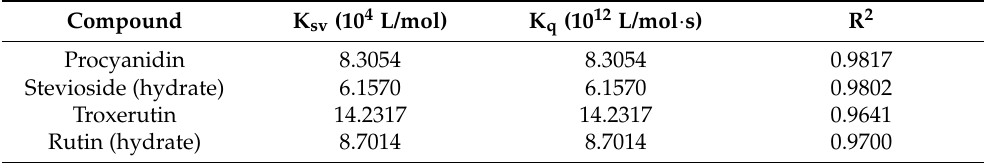
Figure 4. Fluorescence quenching type for the interaction between different compounds and LolB. ( A ): Stern – Volmer plots. ( B ): Plots of compound concentrations vs. changes in fluorescence intensity using One Site-Specific binding model. Table 2. Fluorescence quenching constants of the interaction between active compounds and LolB.